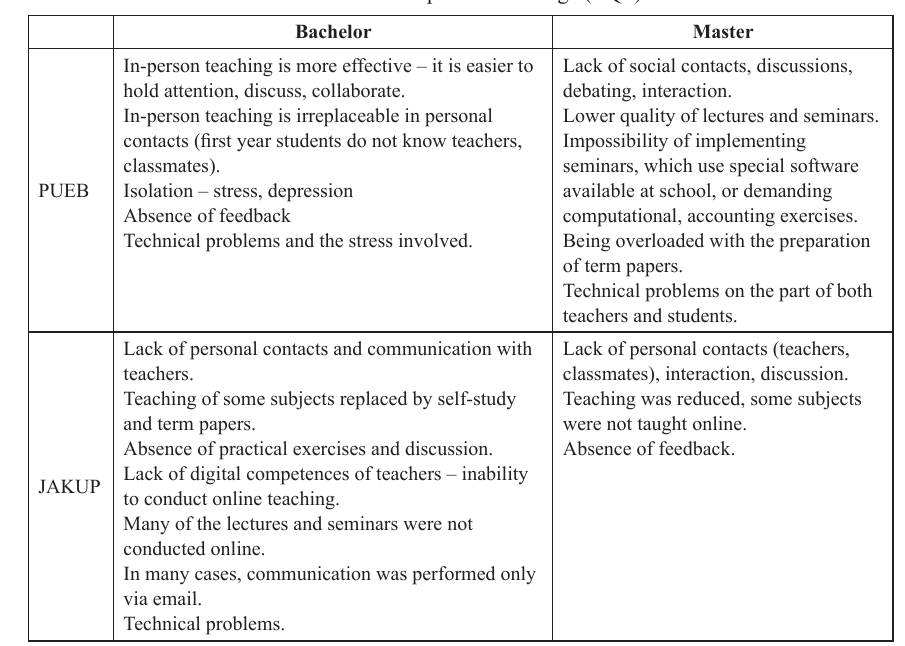
Table 3. What are the reasons for students not accepting online learning as a full-value